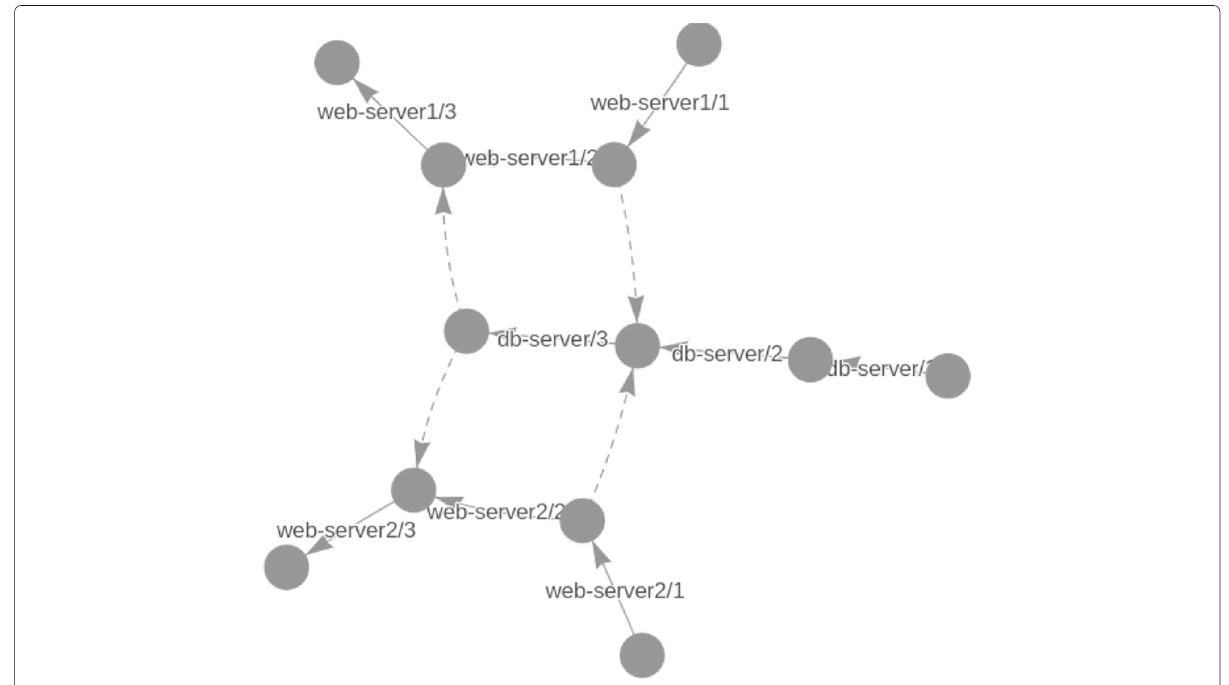
Fig. 3 Wordpress deployment graph with 2 Web Servers and 1 Database Server